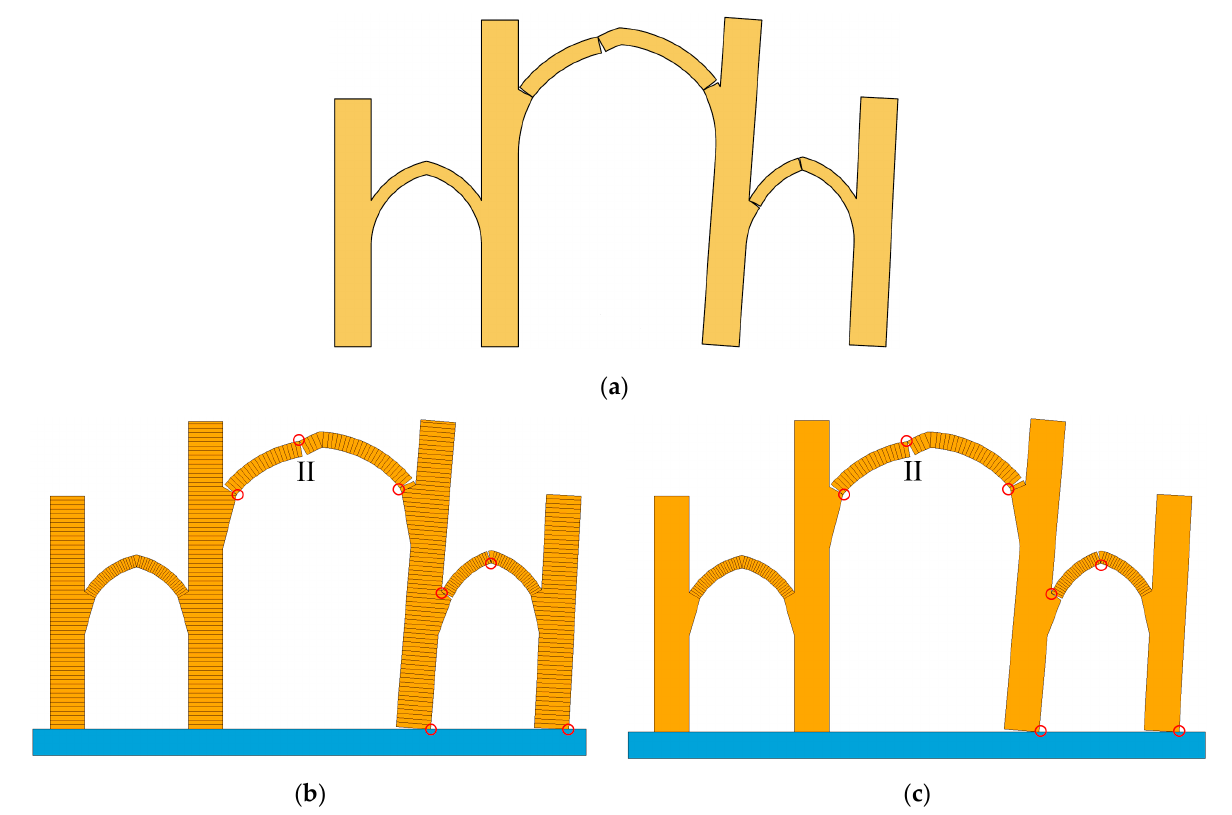
Figure 15. Failure modes of the multi-span pointed arch church: ( a ) limit analysis [47]; ( b ) FDEM result of Scheme A; ( c ) FDEM result of Scheme B.